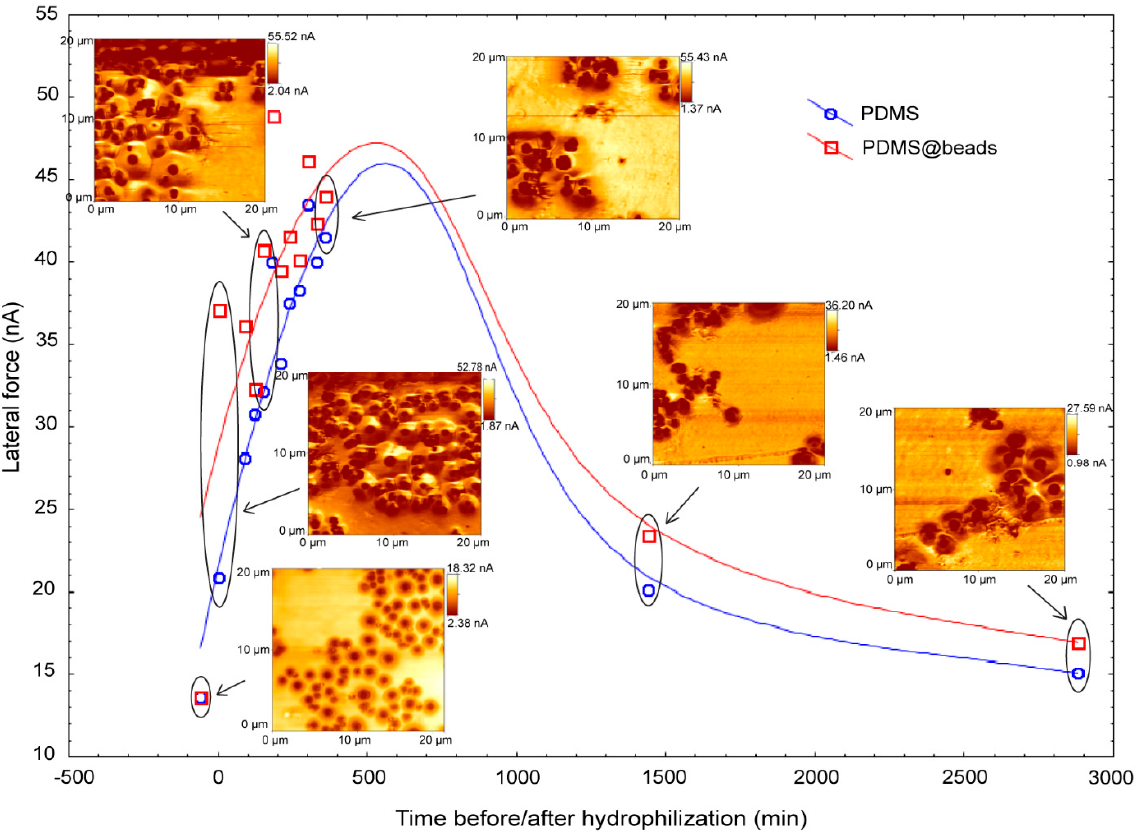
Figure 5. Variation of the lateral force for PDMS surface away (blue) and in the vicinity (red) of hydrophilic entities. The associated later force scans are indicated at the respective positions in time during hydrophobic recovery.